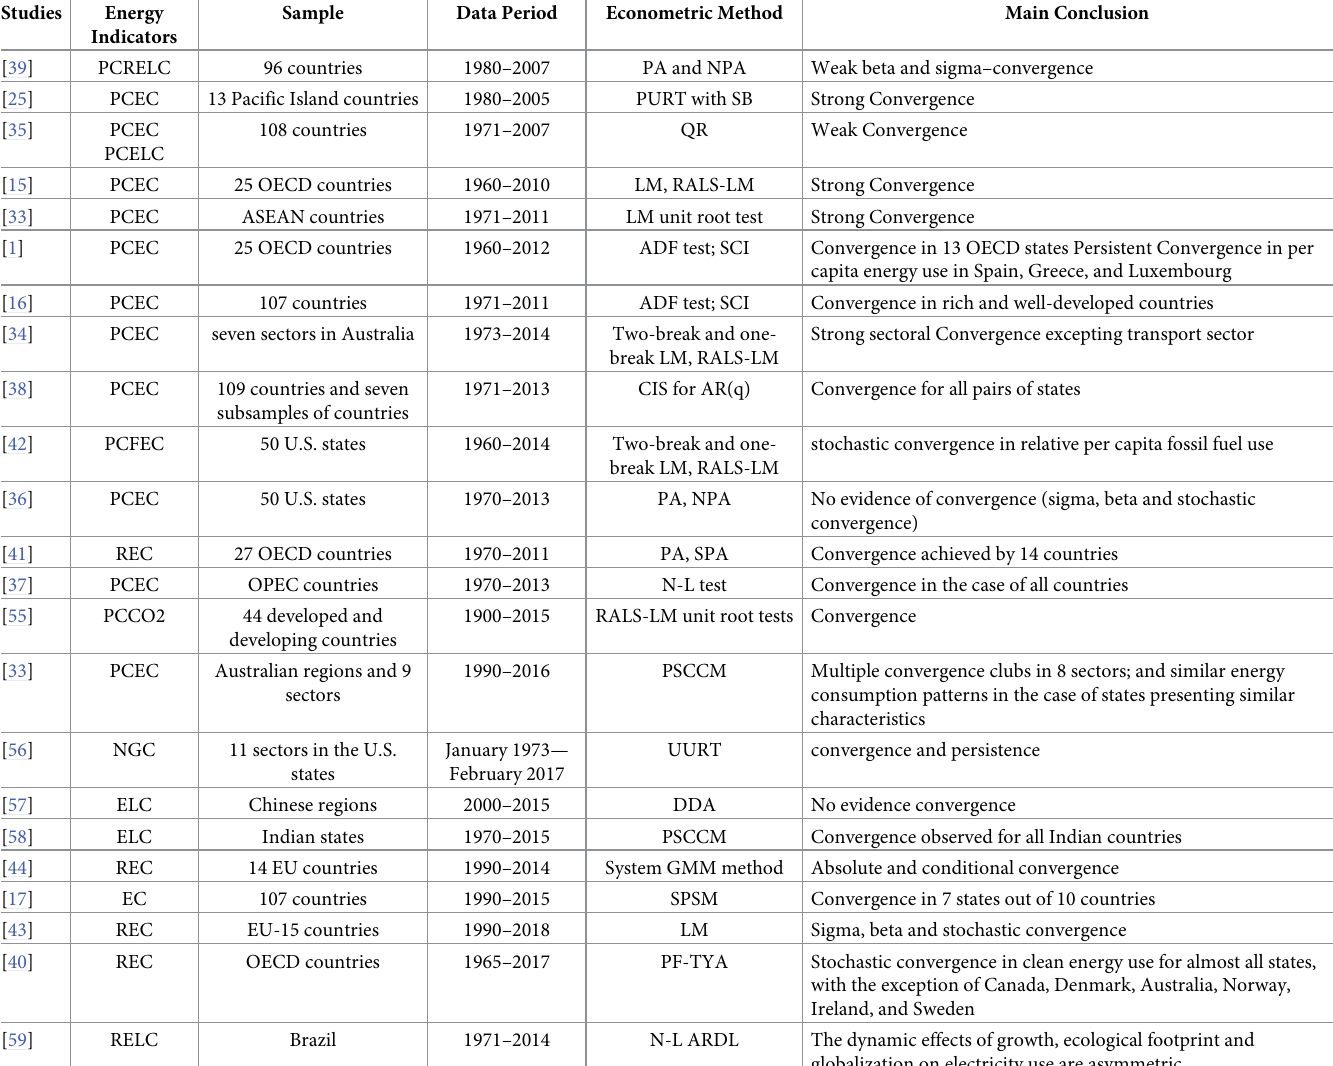
Table 1. Summary of studies assessing the convergence properties of energy